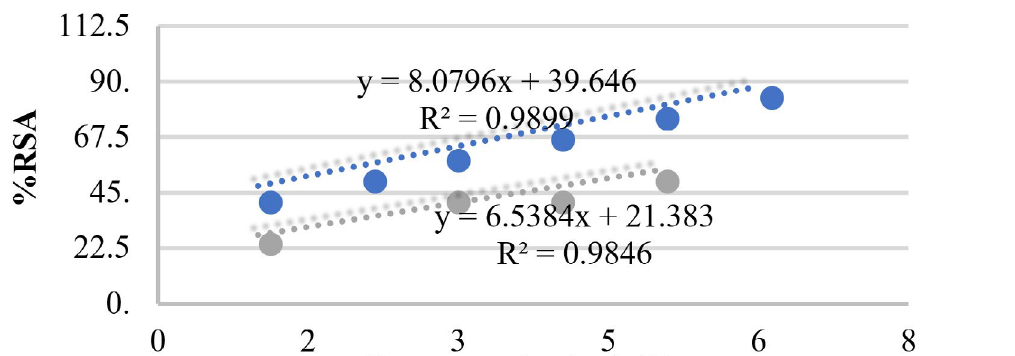
Fig. 3. LC-MS analysis of the extract obtained from pellet.